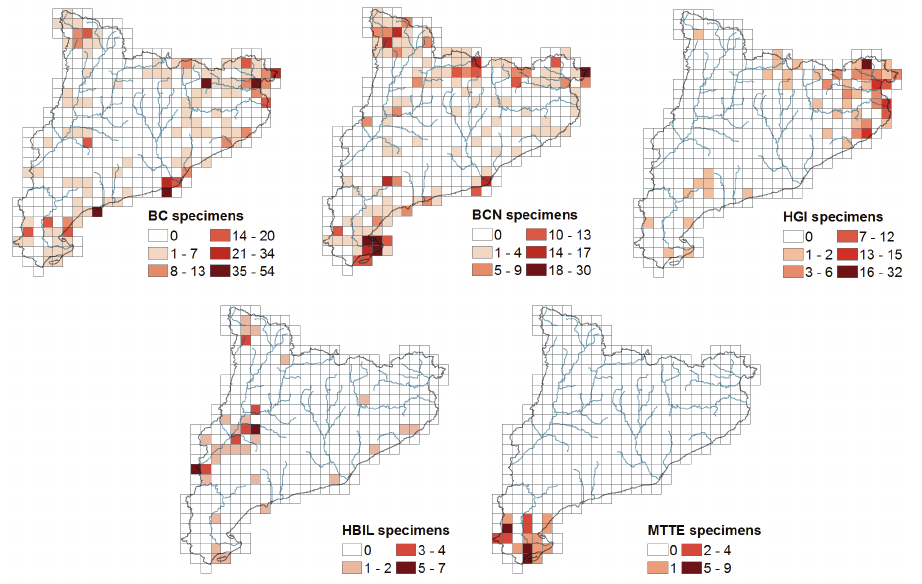
Figure 5. Distribution map of the specimens for UTM grid of 10 km 2 for each